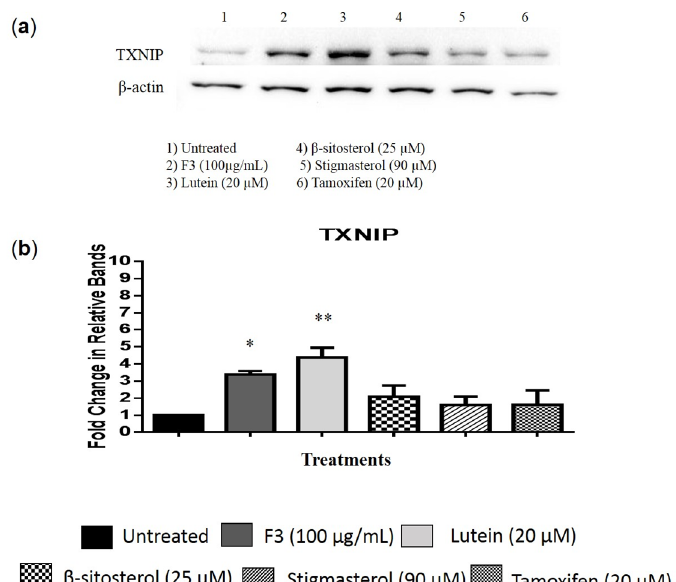
Figure 5. TXNIP protein expression. MDA-MB-231 cells were treated with the indicated concentra- tions of (2) F3, (3) lutein, (4) β -sitosterol, and (5) stigmasterol for 24 h. The protein expression was then determined by Western blotting. ( a ) Representative image of TXNIP protein expression. Tamoxifen was used as a positive control, while untreated cells were used as negative control. ( b ) Results are presented as an average fold change in the level of each protein normalized to β -actin ± SD ( n = 3). * p < 0.05; ** p < 0.01.